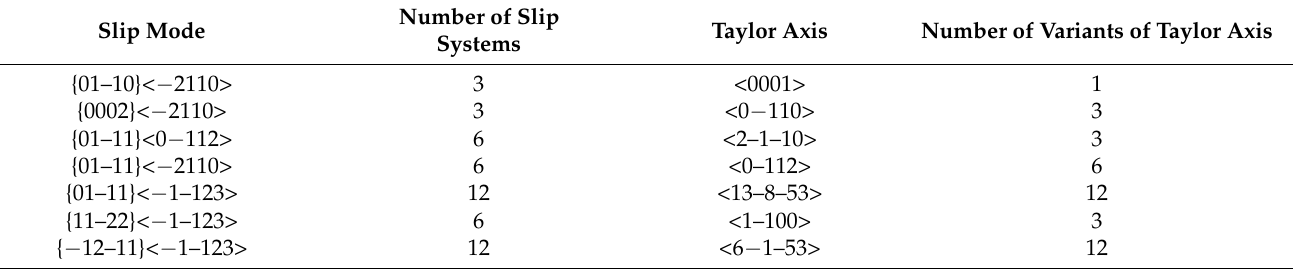
Table 1. Typical slip modes and the corresponding Taylor axes in α -Ti [21,23,26] .